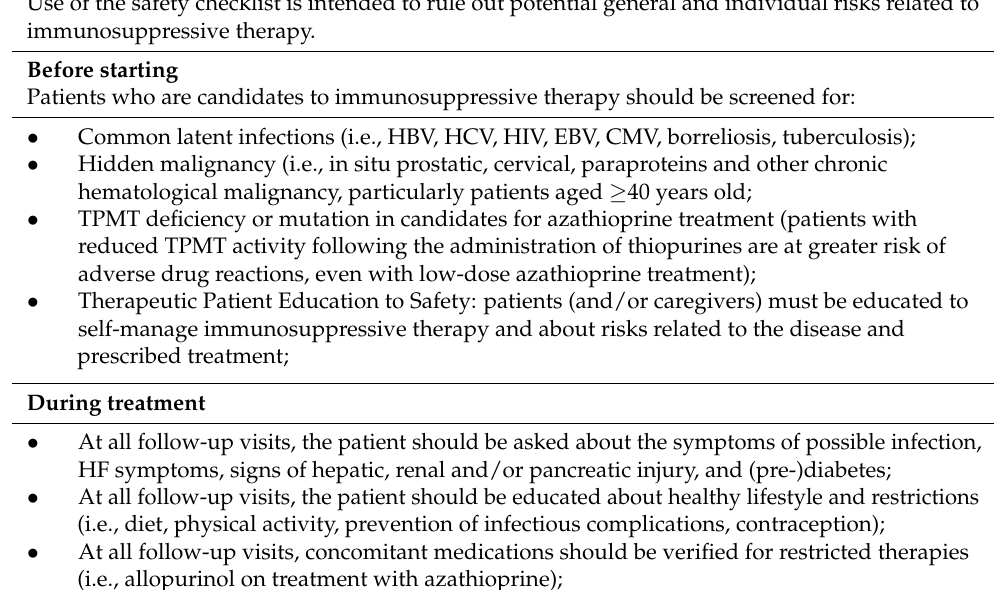
Table 4. Safety checklist used before starting and during immunosuppressive